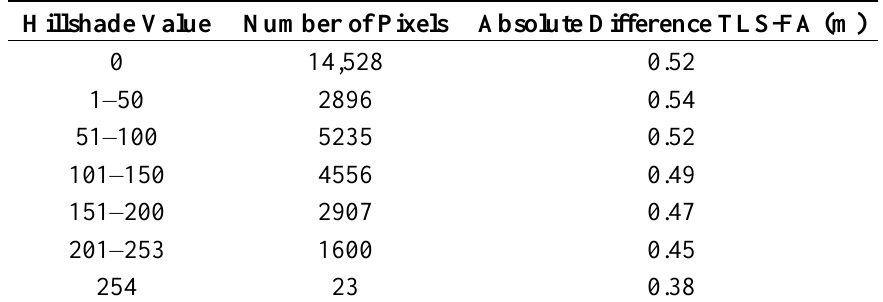
Table 5. Absolute differences to the Terrestrial Laser Scanner Digital Elevation Model (TLS DEM) grouped according hillshade intervals.